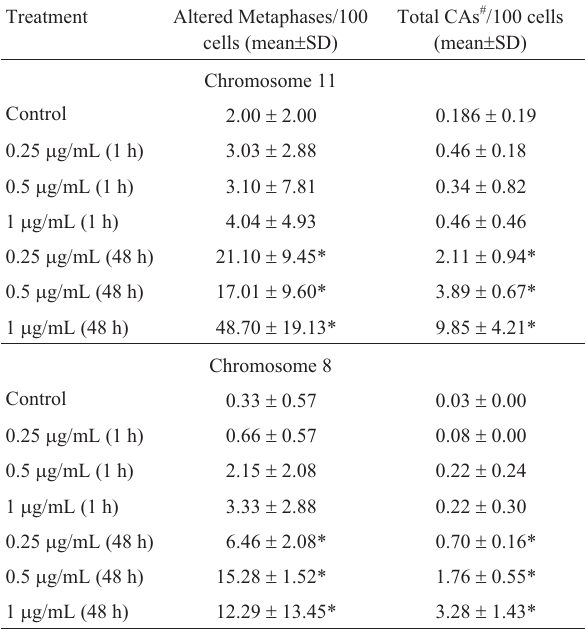
Table 2 - Altered metaphases and chromosomal aberrations (CAs) de- tected with specific probes for chromosomes 8 and 11 in peripheral blood lymphocytes treated with etoposide. 1000 cells were analyzed per treat- ment/experiment.